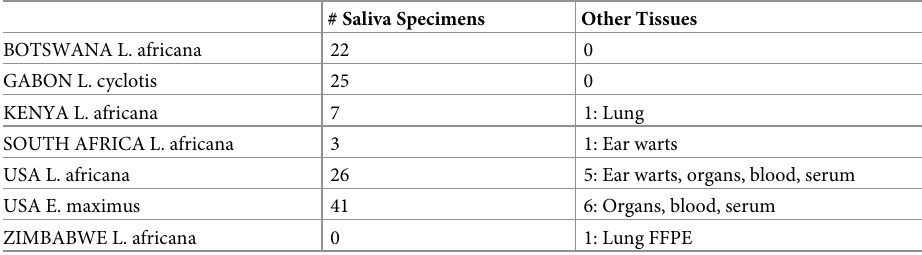
Table 4. Complete set of Cohort 3 specimens (collected by Virginia R. Pearson).